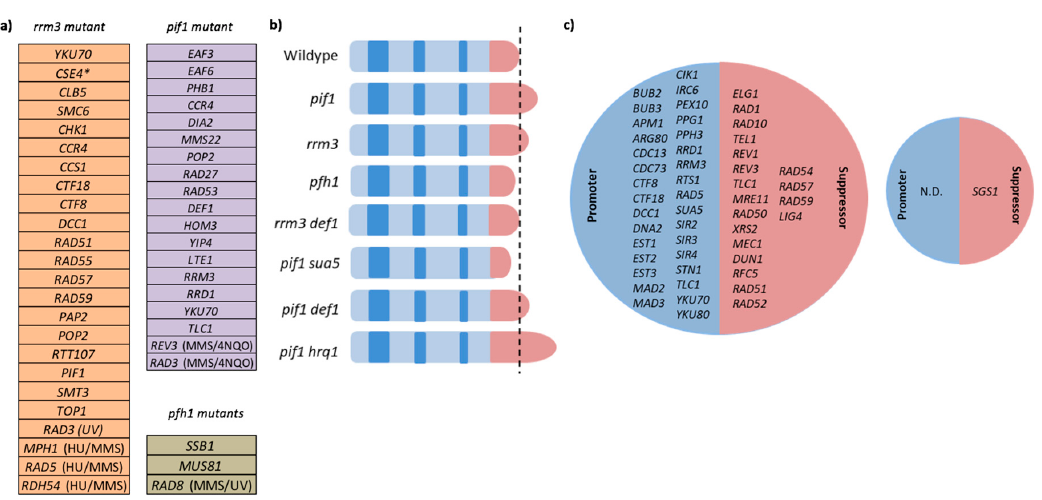
Figure 3. Functional interactions of RRM3 , Sc PIF1 , and PFH1 . ( a ) Synthetic growth defects of rrm3 , pif1, and pfh1 (pfh1-mt* and pfh1-R20 ) mutants. *Overexpression of CSE4 leads to a growth defect in the rrm3 mutant. [51,54,55,62,69,75,77,80–92]. ( b ) E ff ects of pif1 , rrm3, and pfh1-m21 mutations on telomere length [93–96]. Telomeres are depicted in pink and genes are in blue stripes ( c ) Genes that promote or suppress gross-chromosomal rearrangement formation in pif1 (left) and rrm3 (right) mutants. [25,34,48,91,94,97–105].